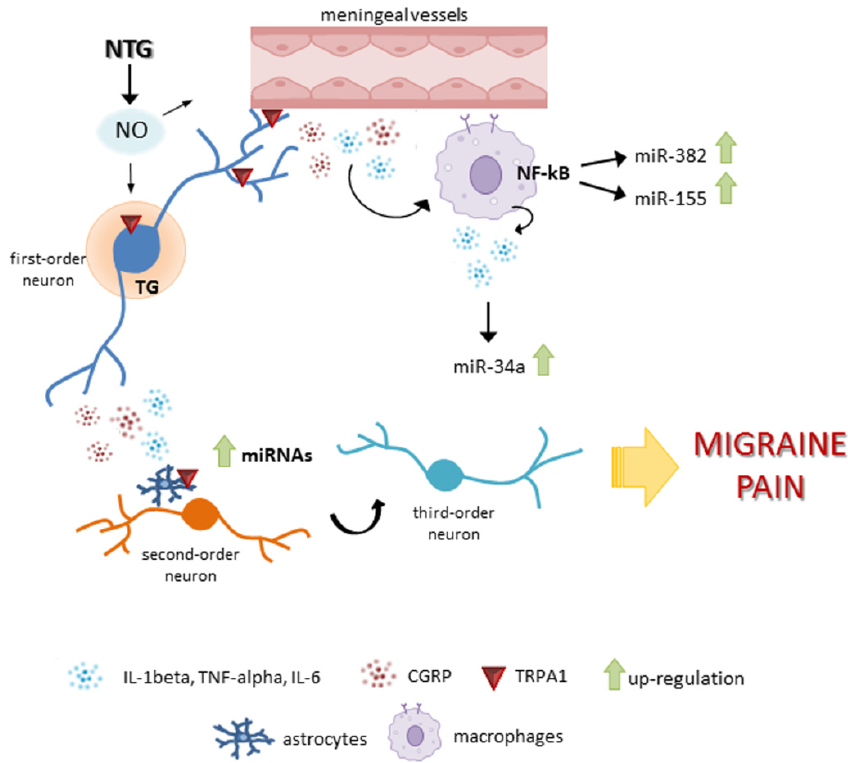
Figure 9. Potential interaction of CGRP with other pain/inflammatory mediators relevant for neu- ronal sensitization in an animal model of chronic migraine. Nitroglycerin (NTG), by releasing nitric oxide (NO), may induce an inflammatory response within the dura mater and the trigeminal gan- glion (TG), potentiated by CGRP release, with an increase in pro-inflammatory cytokines interleukin (IL)-1beta and tumor necrosis factor alpha (TNF-alpha) levels by nuclear factor kappa B (NF- κ B) activation [62,63]. In addition, NTG may activate transient receptor potential ankyrin 1 channels (TRPA1) receptors contributing to a further release of CGRP. This response may induce an upregulation of miRNAs, not only at the peripheral level but indirectly at the central level.